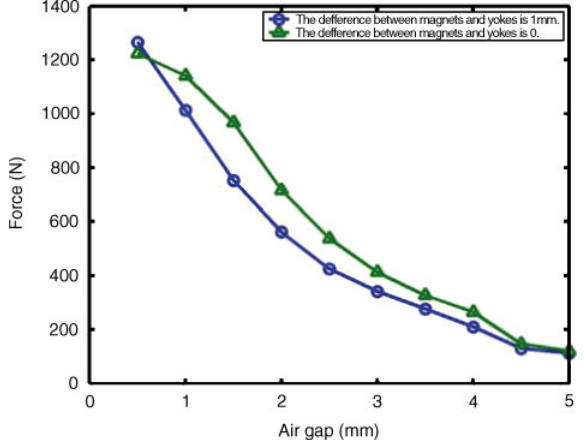
Figure 9 Influence of difference of the height of the magnets and the yokes.